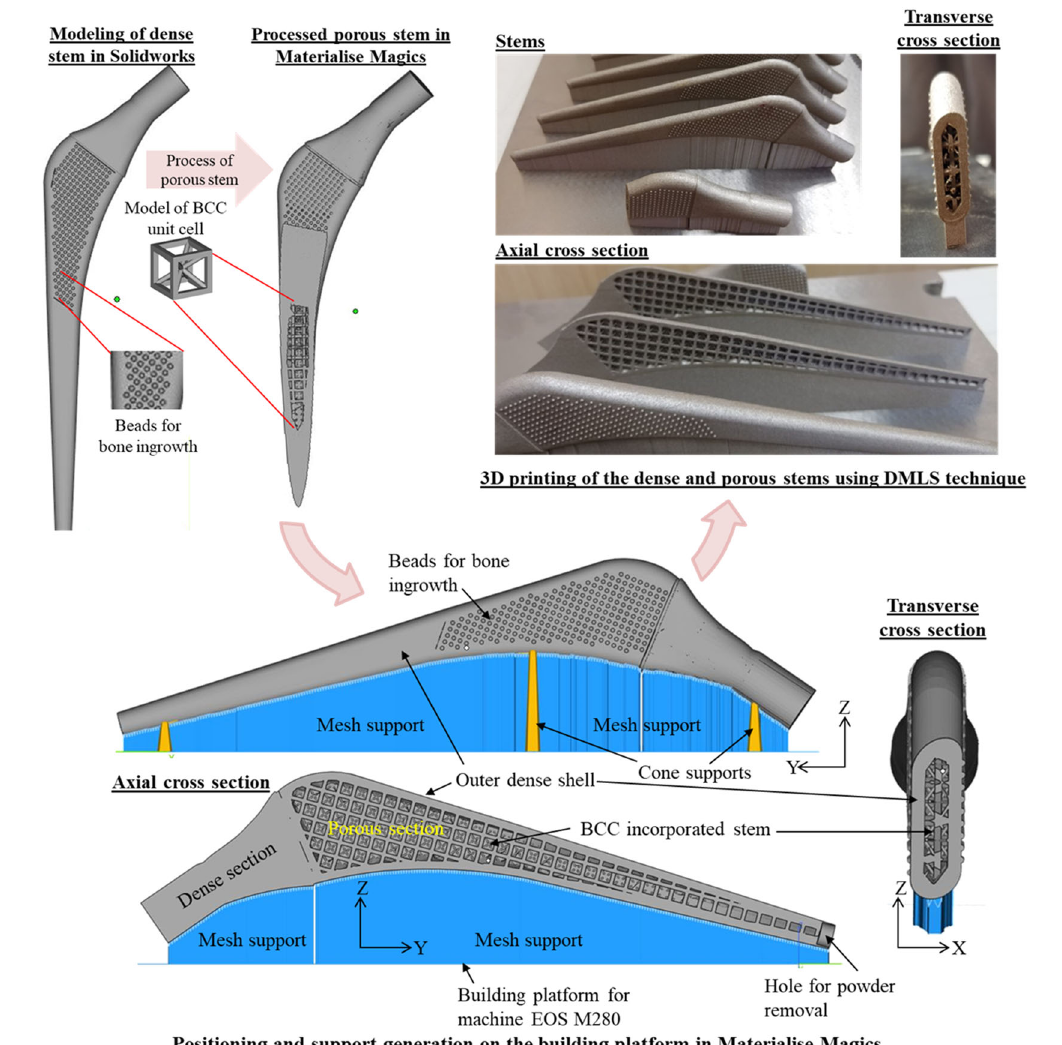
Fig. 9 3D printed porous stems with outer beads using the DMLS technique